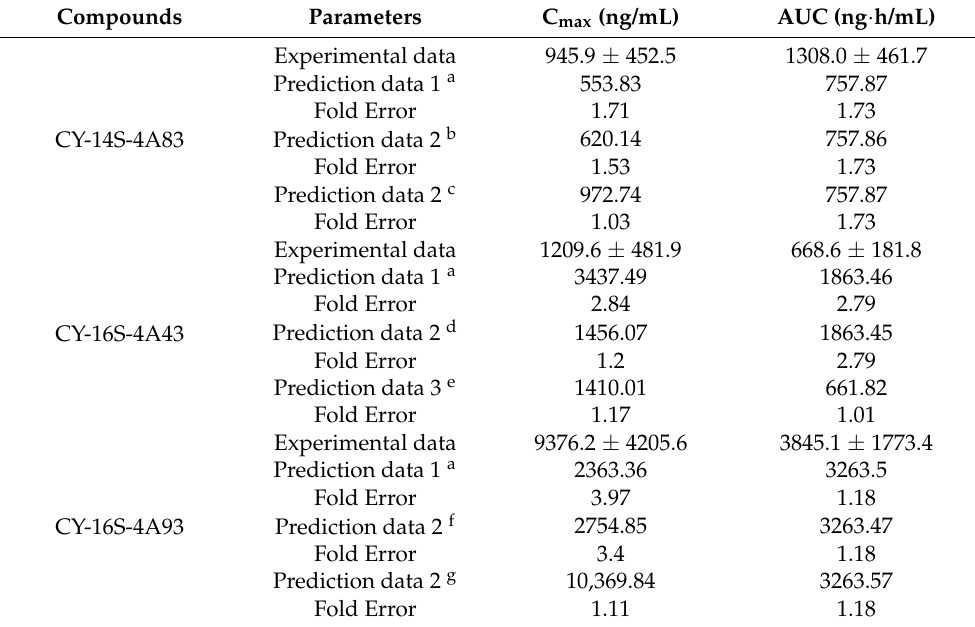
Table 6. Prediction parameters of the PBPK models of CY-14S-4A83, CY-16S-4A43, and CY-16S-4A93.